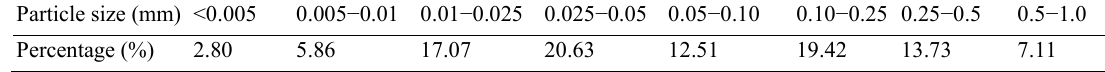
Table 1 Particle size classes of the experimental